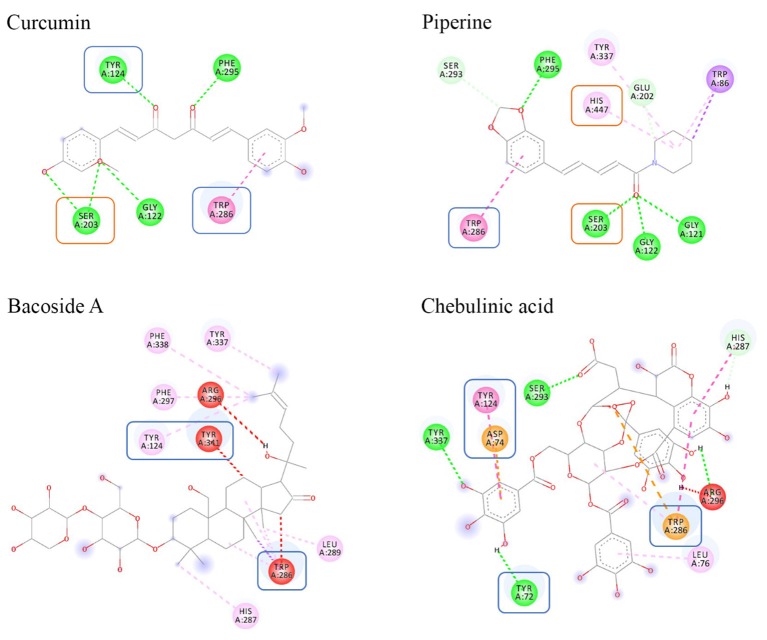
Binding interactions of ligands to AChE. Amino acids in orange box represent CAS residues, blue box for PAS, while the remaining amino acids are residues that were involved in stabilizing the binding within the AChE gorge.